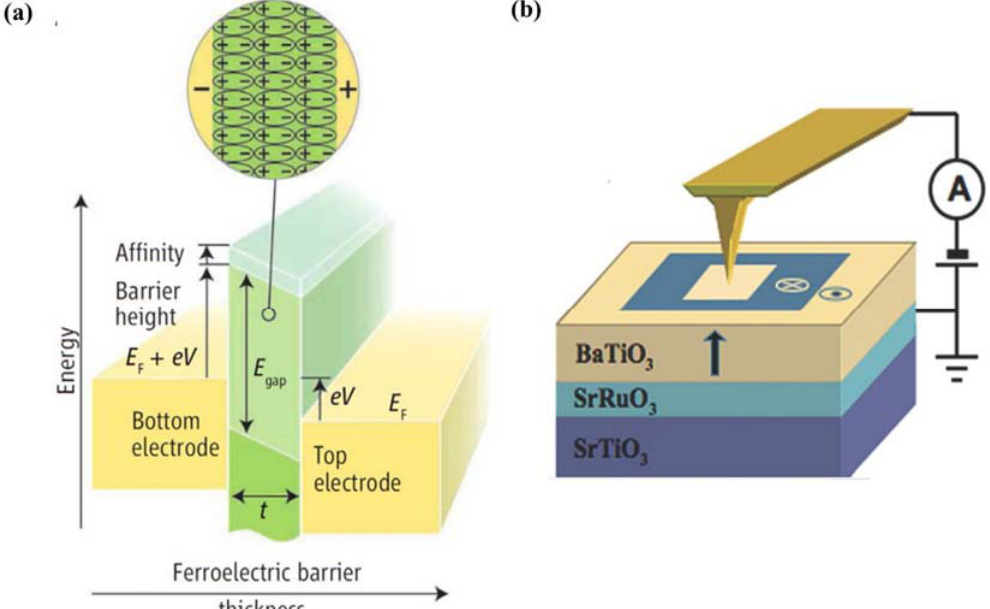
Figure 13. ( a ) Schematic viewgraph of a ferroelectric tunnel junction which consists of two electrodes separated by an nm-thick ferroelectric barrier layer (cited from Tsymbal et al. [381]); ( b ) sketch illustrating the geometry of experiment for PFM/c-AFM studies of tunneling electroresistance effect in ultrathin BaTiO 3 films (Gruverman et al.